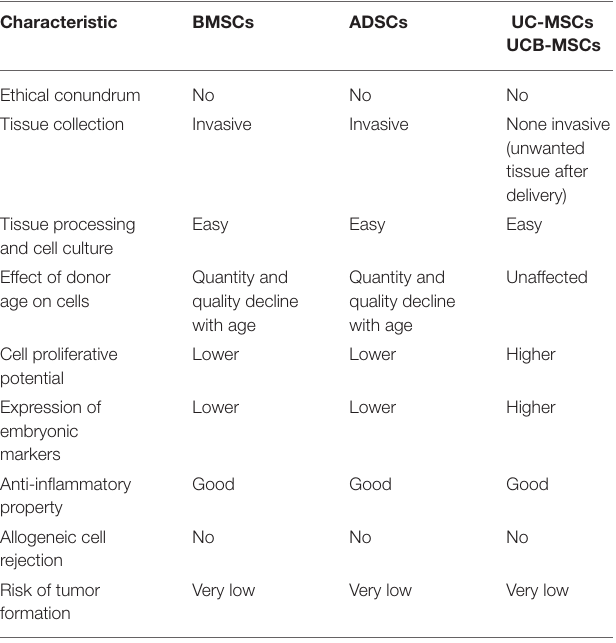
TABLE 1 | Comparison between BMSCs, ADSCs, UC-MSCs and UCB-MSCs for stem cell therapy. Characteristic BMSCs